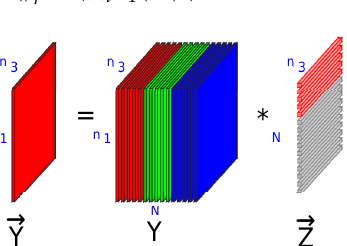
norm and ( e ) l 0 norm, 2